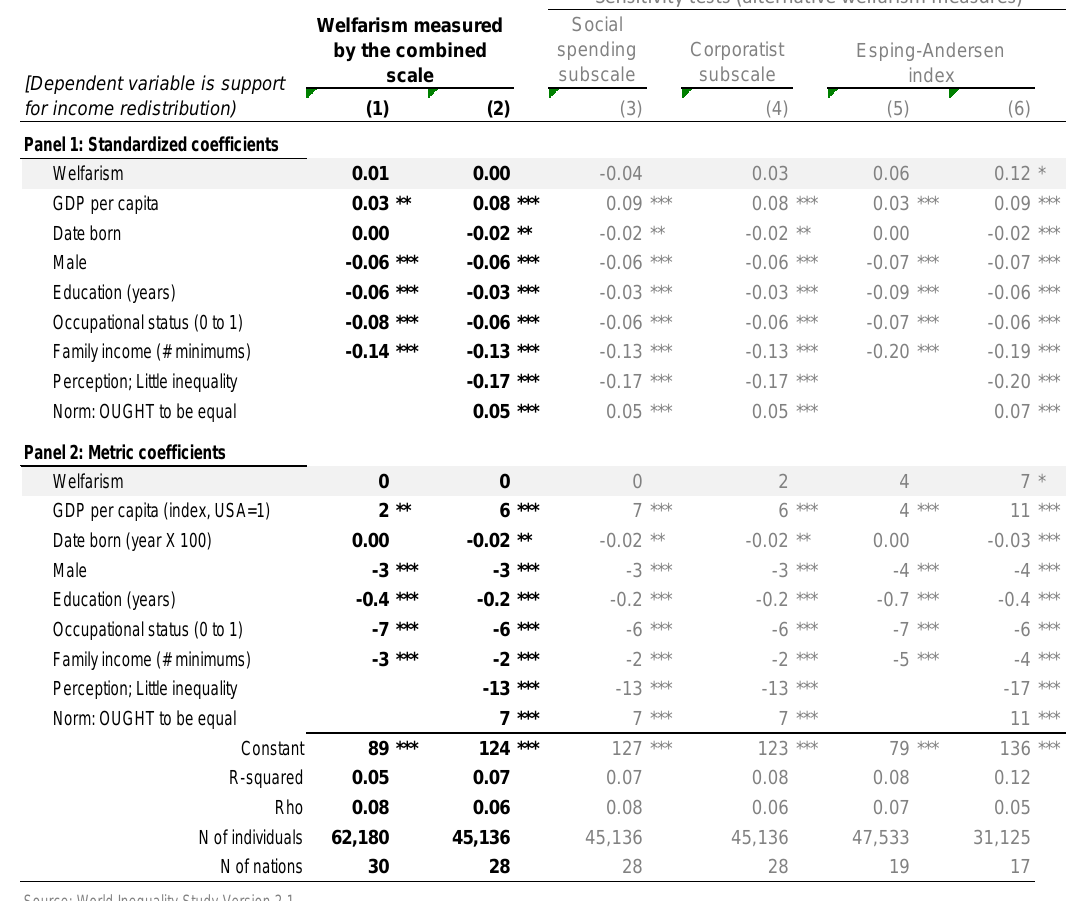
Figure 14. Welfarism and attitudes toward income redistribution. Welfarism measured in four alternative ways. Multilevel regression estimated by GLS. Individual level data for 30 nations, 1987–2009.